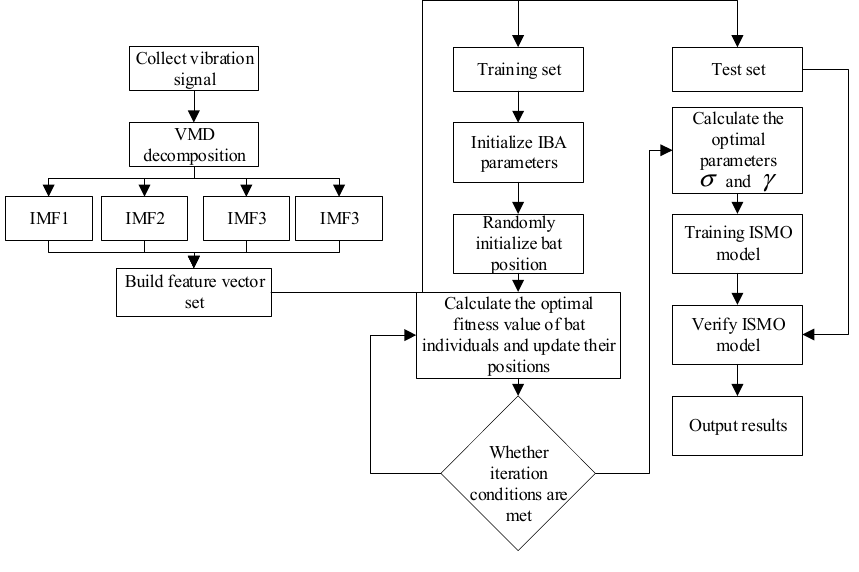
Figure 1. The model of fault diagnosis.